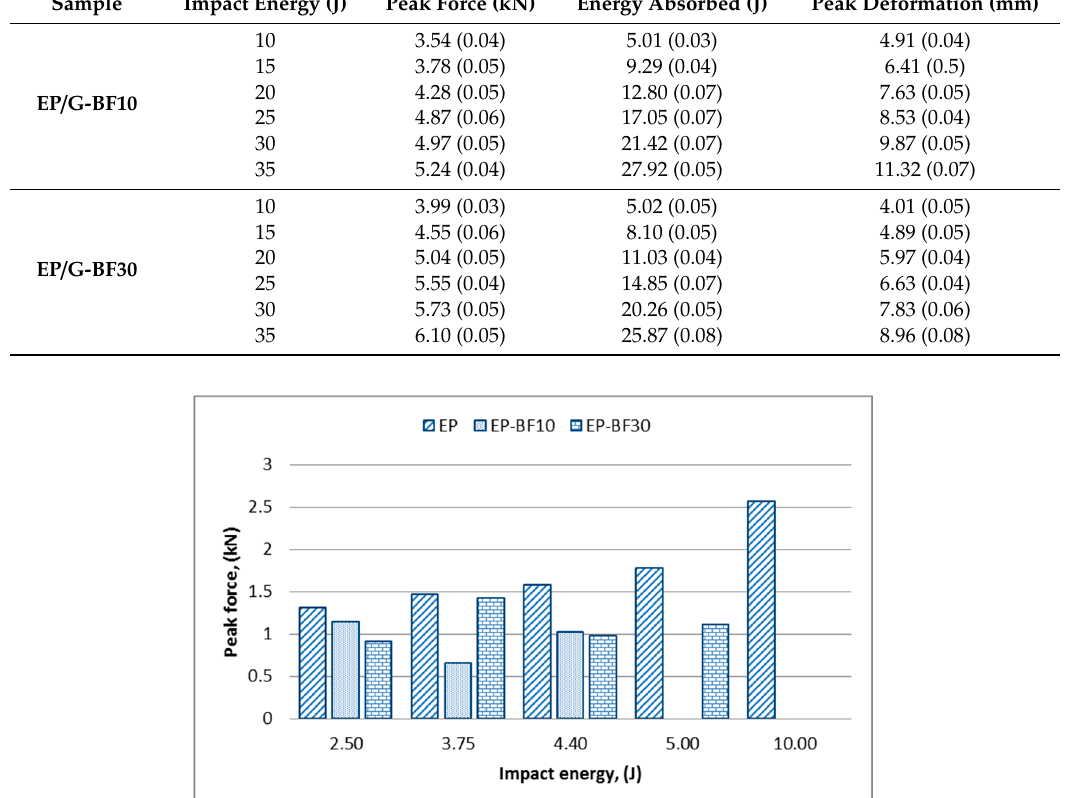
Figure 3. Variation of the peak force for the EP and EP-BF composites at the first range of impact energy levels.